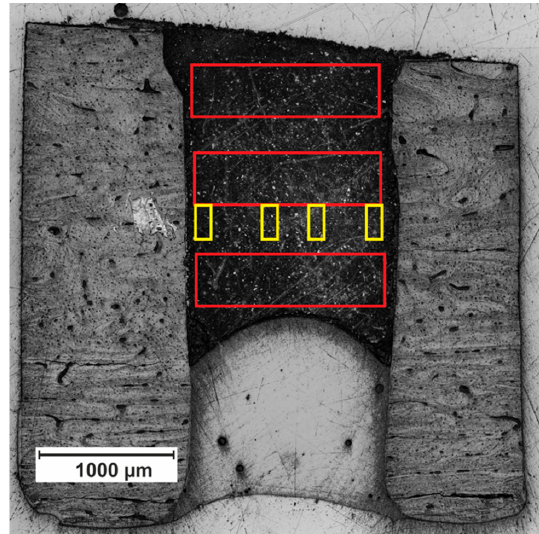
Figure 1. Specimen cross-section. Red rectangle marked position of matrices used in Study-I. Yellow rectangle marked position of detailed matrices used in Study-II.